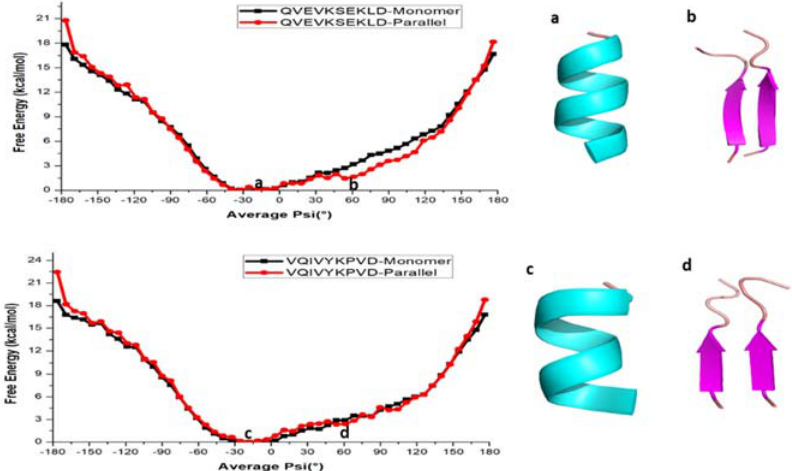
Figure 3. Free energy profile of various conformations of QVEVKSEKLD and VQIVYKPVD respectively. ( a , b ) helical and β -sheet of QVEVKSEKLD, ( c , d ) helical and β -sheet of VQIVYKPVD.